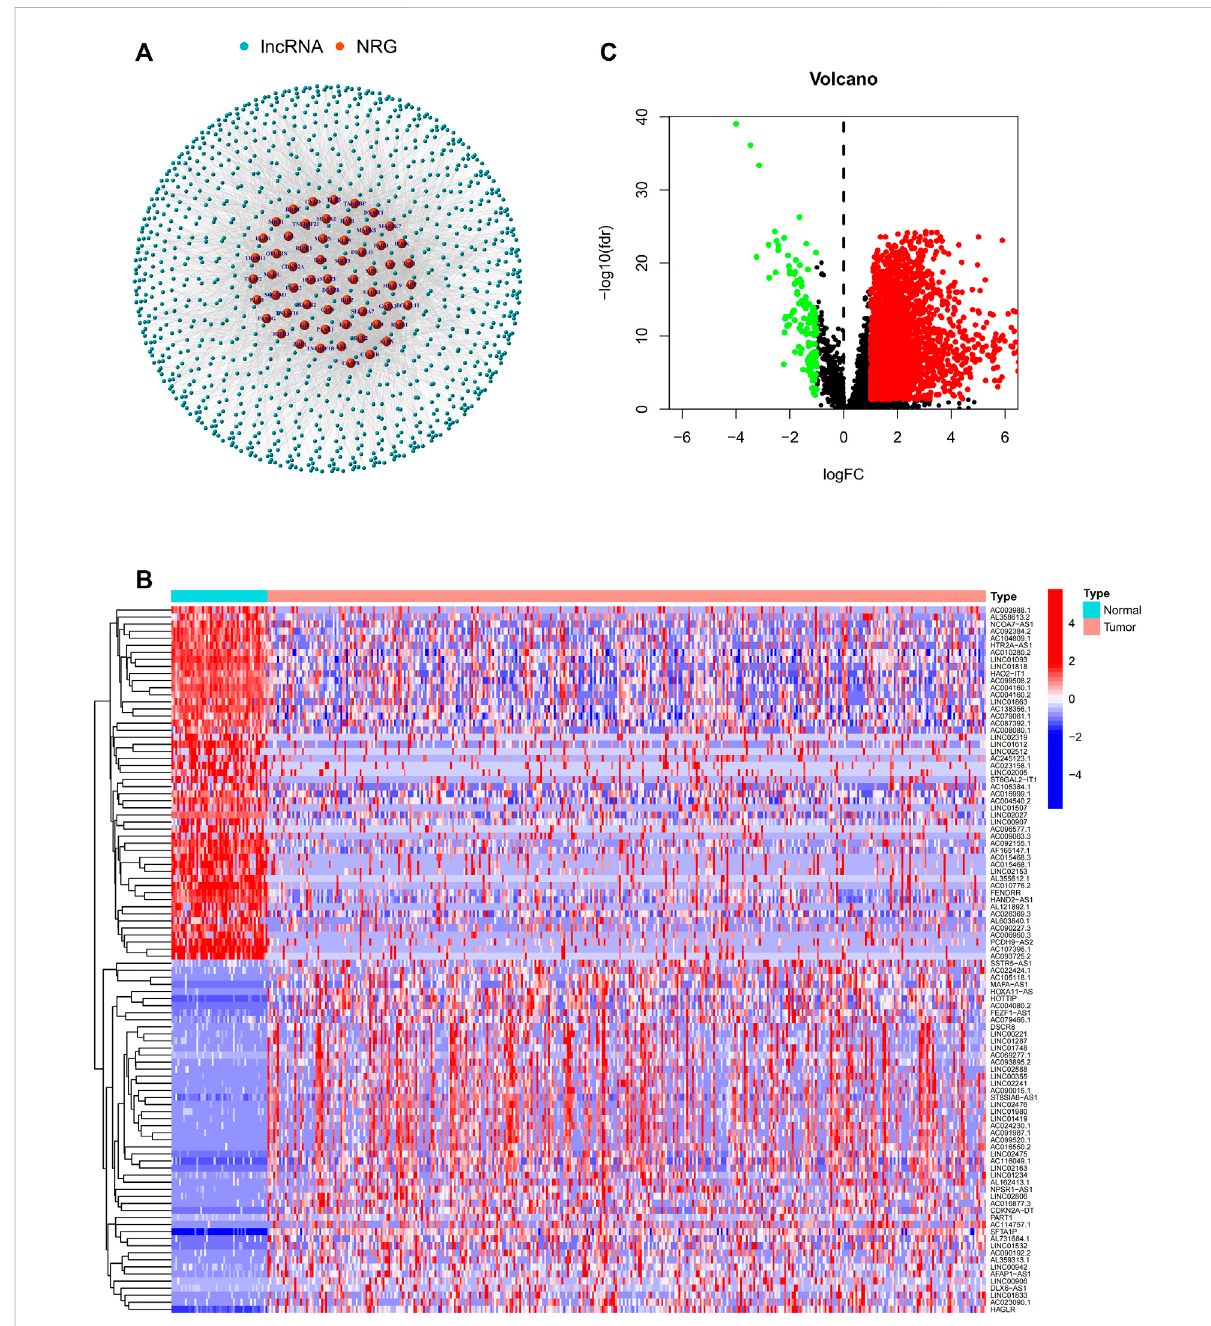
FIGURE 2 (A) Co-expression networkbetweennecroptosis-related genes and lncRNAs. (B) Differential expression of DEGs intumor and adjacent normal pairs. (C) A volcano map shows DEGs. DEG: differentially expressed